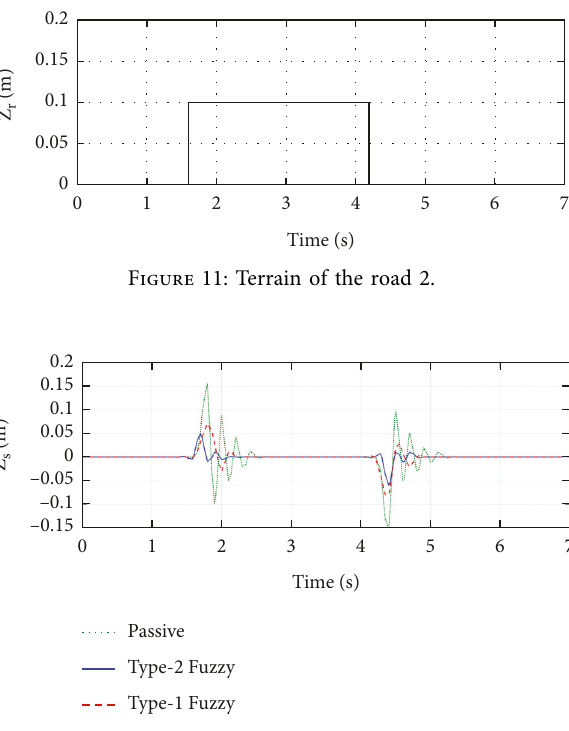
Figure 7: Body displacement.